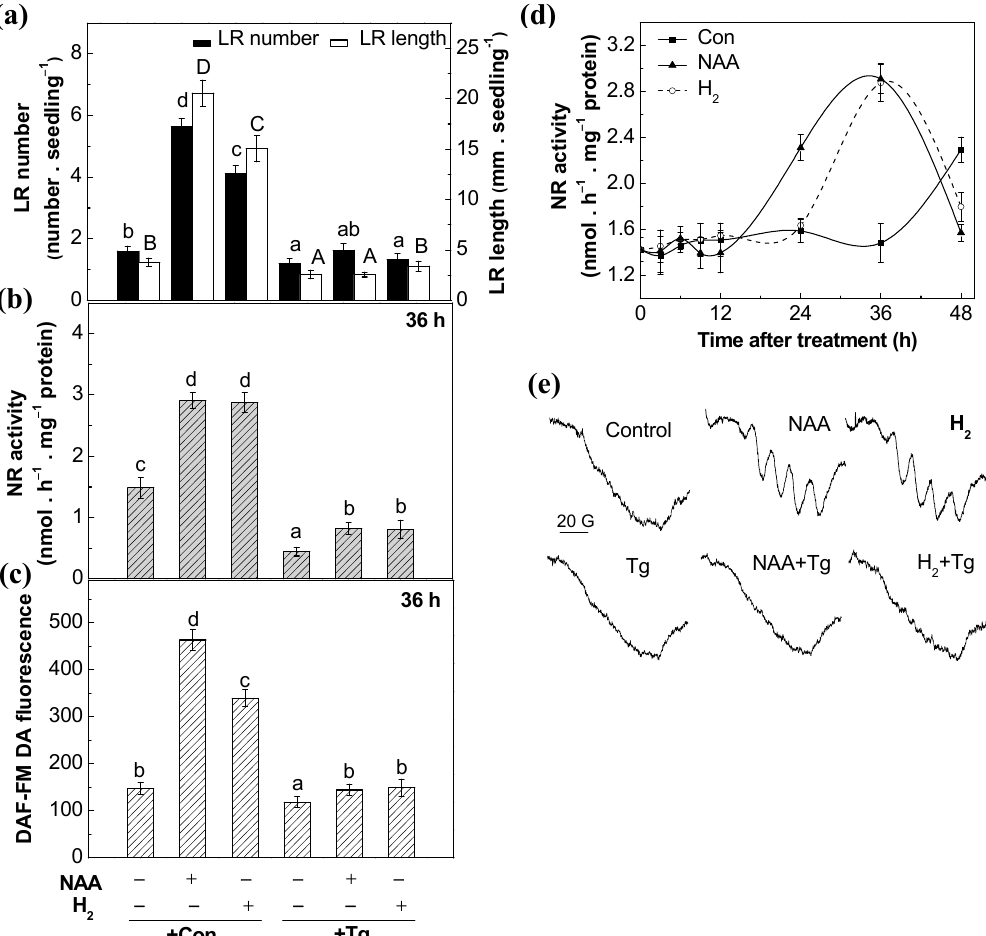
Figure 4. NR might be the enzymatic source of H 2 -triggered NO generation. 3-day-old tomato seedlings were incubated with solutions containing 200 nM NAA, 0.39 mM H 2 , and 20 µ M tungstate (Tg), alone or the combination treatments. ( a ) The number of emerged LRs (>1 mm) per seedling and LR length were calculated after 3-day of treatments. Meanwhile, the activity of nitrate reductase (NR) was determined at 36 h ( b ) and over 48 h ( d ) of treatments, respectively; ( c ) The NO fluorescence in tomato roots was analyzed by fluorescence probe DAF-FM DA at 36 h of treatments, using LSCM (TCS-SP2 system; Leica Lasertechnik GmbH). The DAF-FM DA fluorescence density was analyzed using Leica software; ( e ) The NO signal was also detected by EPR after being treated for 36 h. Distilled water was used for the control (Con) treatment. Data are the means ± SE of three independent experiments with at least three replicates for each ( n = 60 for lateral root formation analysis; n = 5 for NR activity and NO detection). Within each set of experiments, bars denoted by the same letter did not differ significantly at P < 0.05 level according to Duncan’s multiple range test.